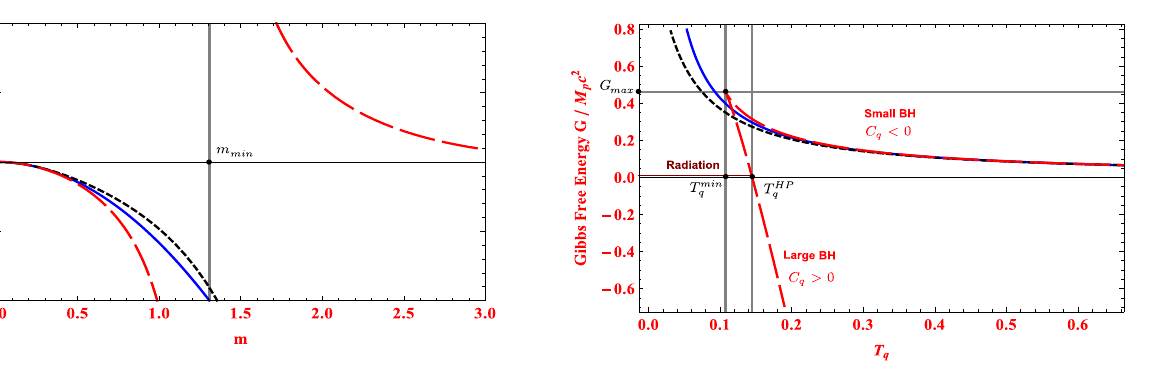
Fig. 3 The figure shows the heat capacity of a Schwarzschild BH as a function of masses in the asymptotically flat case with Boltzmann ( q = 1, blue-continuous) and Tsallis entropies ( q > 1, red-dashed and q < 1, black-dotted)